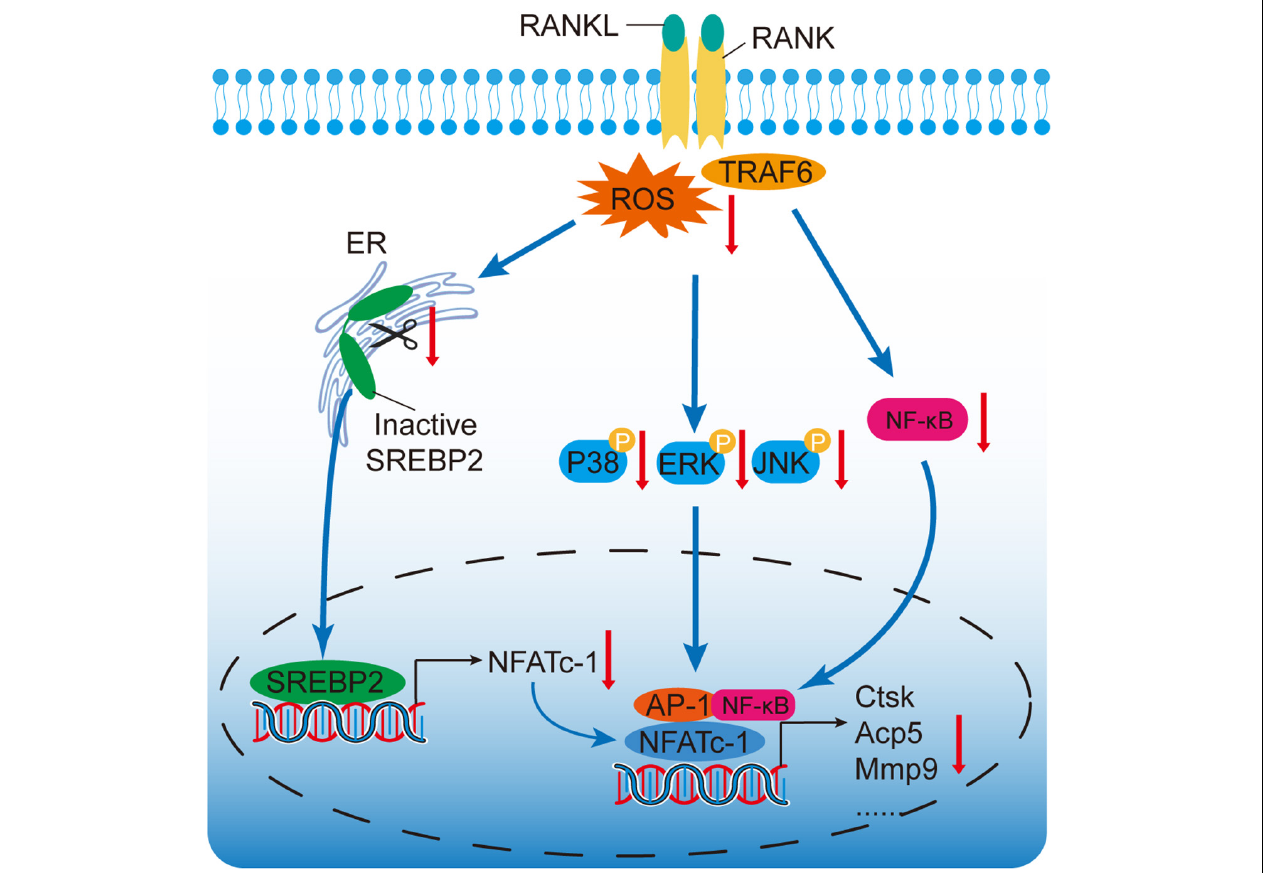
FIGURE 7 | A proposed scheme for the mechanism by which OMT attenuates osteoclastogenesis via modulation of ROS-mediated SREBP2 Signaling. RANKL stimulation could induce ROS generation and activate downstream MAPK and NF- κ B pathways. Active-SREBP2 transcriptionally controls the expression of NFATc1 and promotes osteoclastogenesis. OMT, a quinazine alkaloid, suppresses ROS levels, which attenuates the activation of SREBP2, MAPK, and NF- κ B pathways, subsequently leading to attenuation of NFATc1 and osteoclastogenesis.